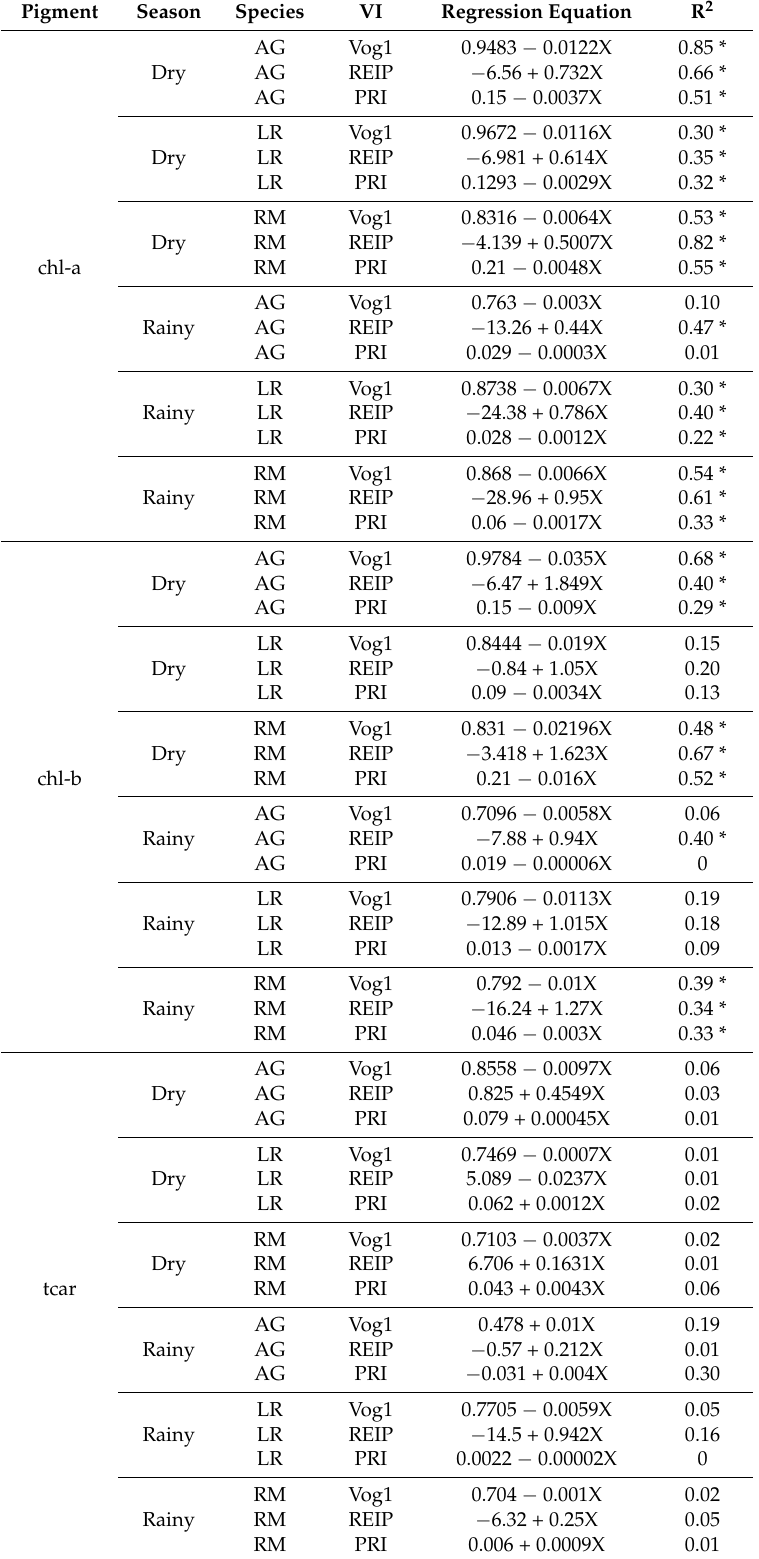
Table 3. Regression analysis of vegetation indices with leaf pigment chlorophyll-a, chlorophyll-b, and total carotenoids for the stressed mangrove classes: Avicennia germinans (AG), Laguncularia racemosa (LR), and Rhizophora mangle (RM). * Critical F -observed value at 4.1 ( α =